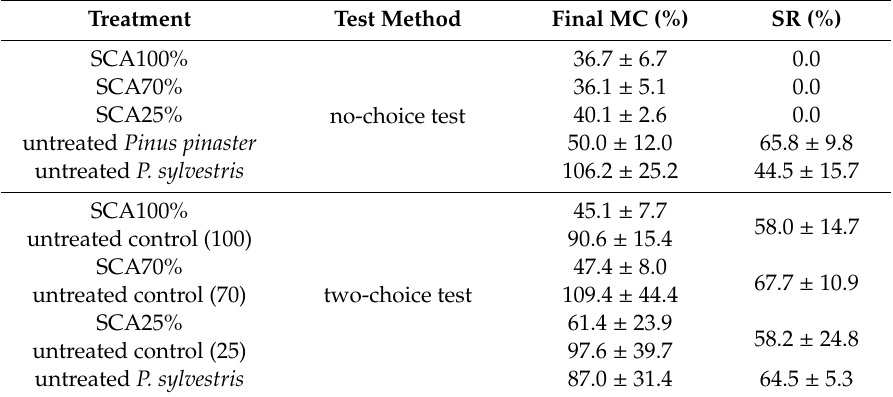
Table 3. Wood moisture content (MC) and termite survival rate (SR) after termite exposure in a no- choice test and a two-choice test.